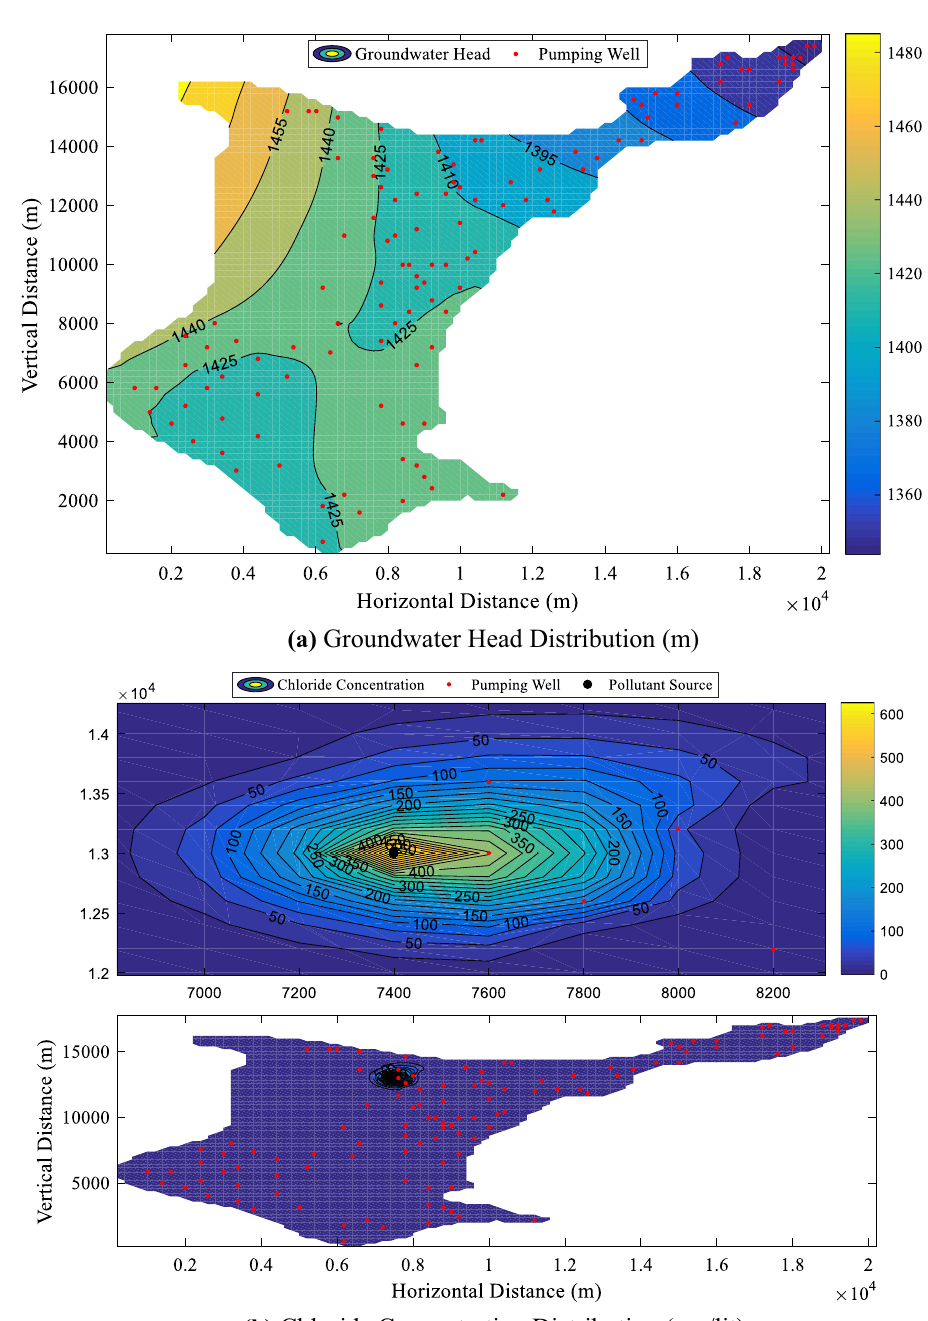
Fig. 12 Groundwater head and contaminant distribution after 5